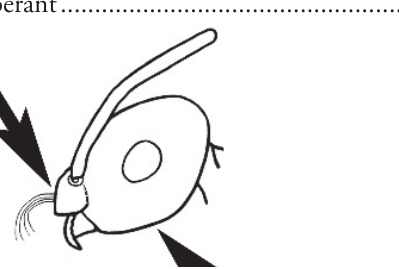
worker mesosoma glossy and unsculptured or with vestigial microreticulation on mesopleuron and propodeum only, and pronotum does not protrude above the mesosomal outline when seen in profile .................................... 56 Smaller species (minor worker HW 0.40 mm ≤, largest major worker HW 1.05 mm ≤); in profile, minor worker head ovate without distinct dorsoventral flattening; major worker with posterior clypeal margin not arched or falling away between antennal insertion and tentorial pit; anterior clypeal margin